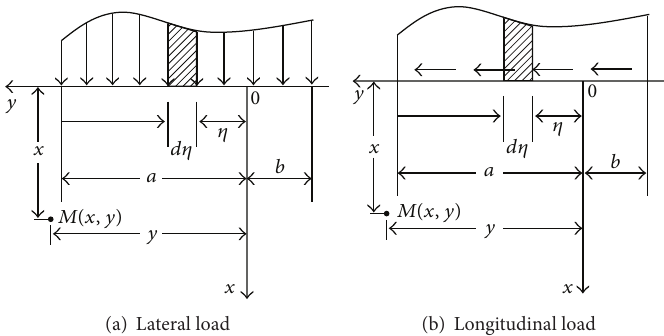
Figure 6: Schematic diagram of stress calculation of coal seam floor with distributed load.